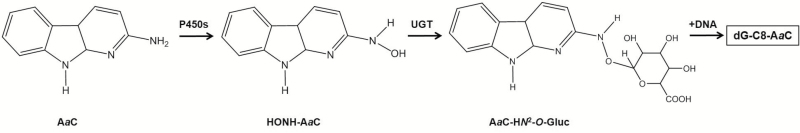
P450-mediated bioactivation pathway of AaC.